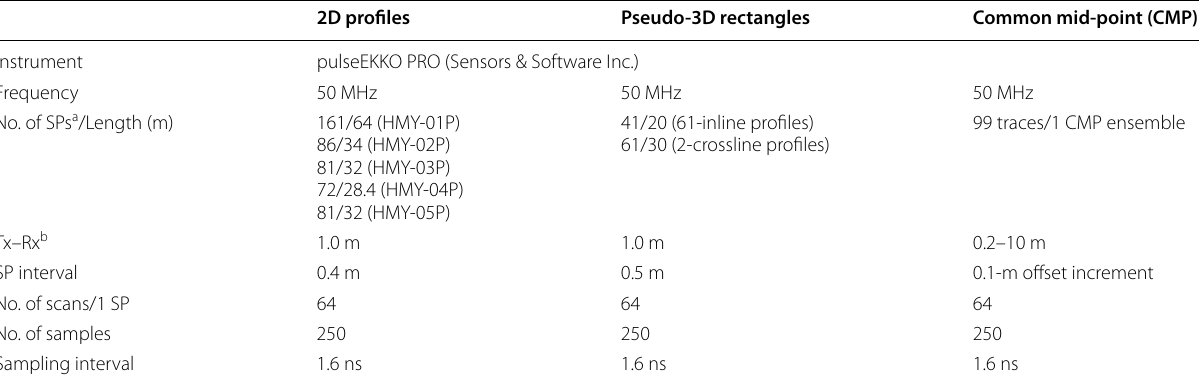
Table 1 GPR data acquisition